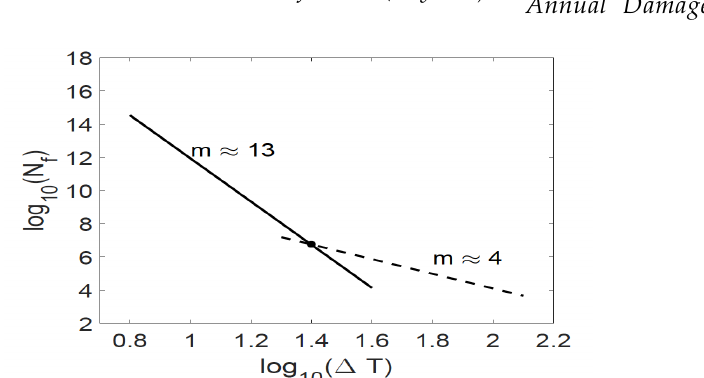
Figure 10. Number of cycles to failure is presented as a function of temperature cycling for a constant mean junction temperature [21].